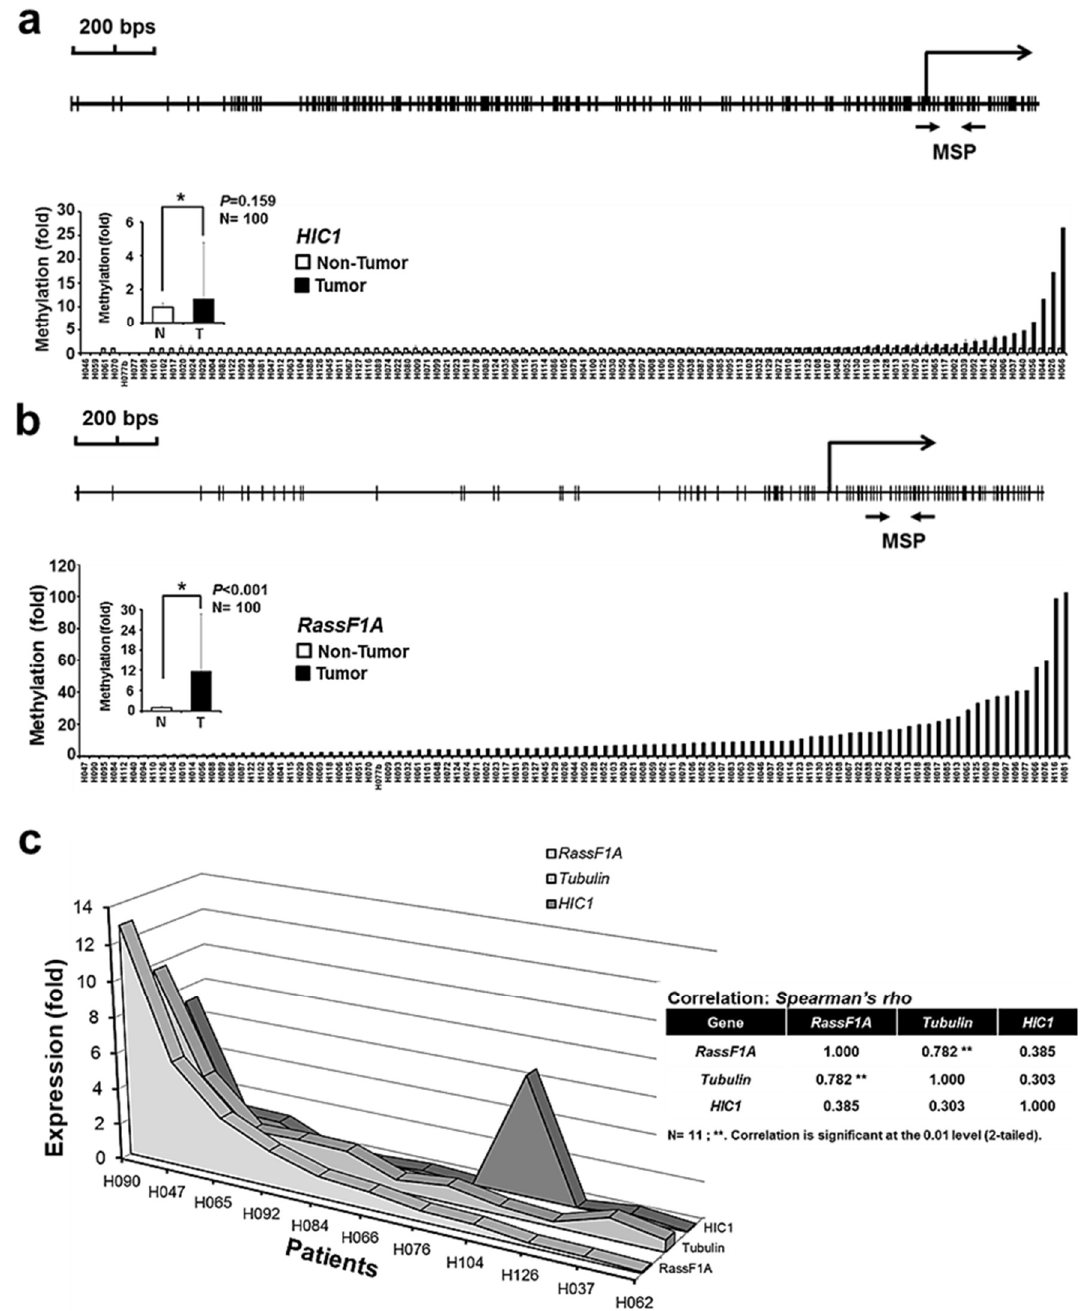
Figure 5. Abnormal HIC1 and RassF1A methylation and the associated loss of tubulin expression are observed in human liver cancers. ( a ) HIC1 and ( b ) RassF1A methylation states were detected in 96 liver cancer samples. The filled histogram indicates the methylation states from the tumor tissue, whereas the open histogram shows the methylation states from the adjacent normal tissue. ( c ) Tubulin expression was associated with RassF1A expression. Total RNAs from five pairs of hypomethylated and six pairs of hypermethylated liver cancer were isolated, and qRT-PCR was performed to examine HIC1, RassF1A, and tubulin expression. Spearman’s correlation analyses were used to identify a significant correlation between RassF1A and tubulin expression.